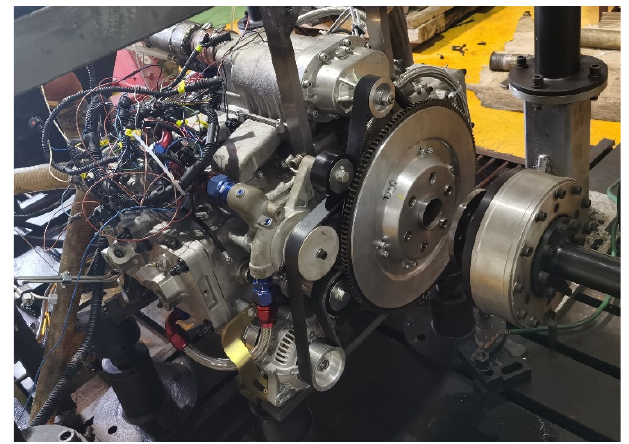
Figure 12. Bench test.